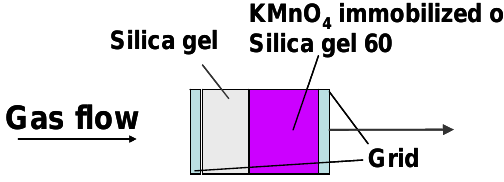
Figure 22. Schematics of the NO to NO 2 converter for human breath analysis. The gas passes through a two stage filter that dehumidifies and performs the oxidative conversion.